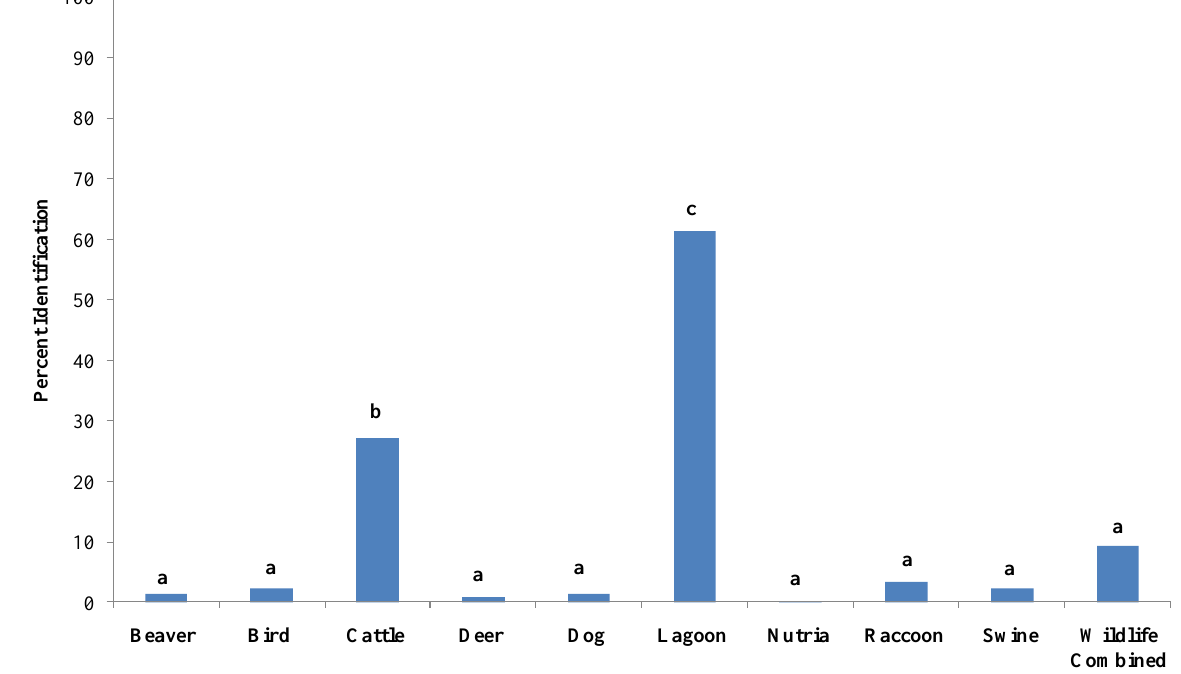
Host source identifications. Bars with the same letters are not significantly different (Tukey–Kramer (HSD) test